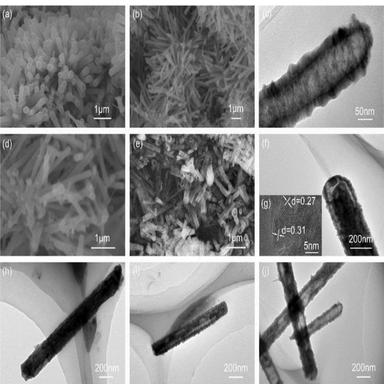
(a, b, d, e) SEM images of products with desulfurization times of 30 h, 35 h, 40 h and 45 h; (c, f) TEM images of 40 h desulfurization products; (g) HRTEM of 40 h desulfurization products; (h–j) TEM images of products with desulfurization times of 10 h, 30 h and 40 h.